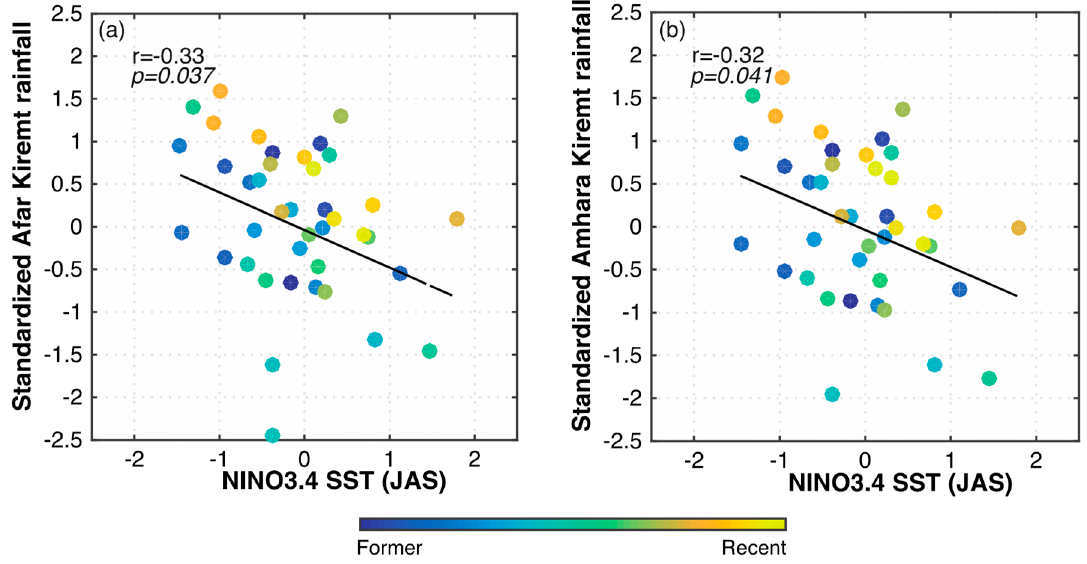
Figure 3. Correlations between regional Kiremt rainfall and July–September NINO3.4 sea surface temperatures (SSTs) averages for ( a ) Amhara and ( b ) Afar. Color shades represent individual years between 1966 and 2006.